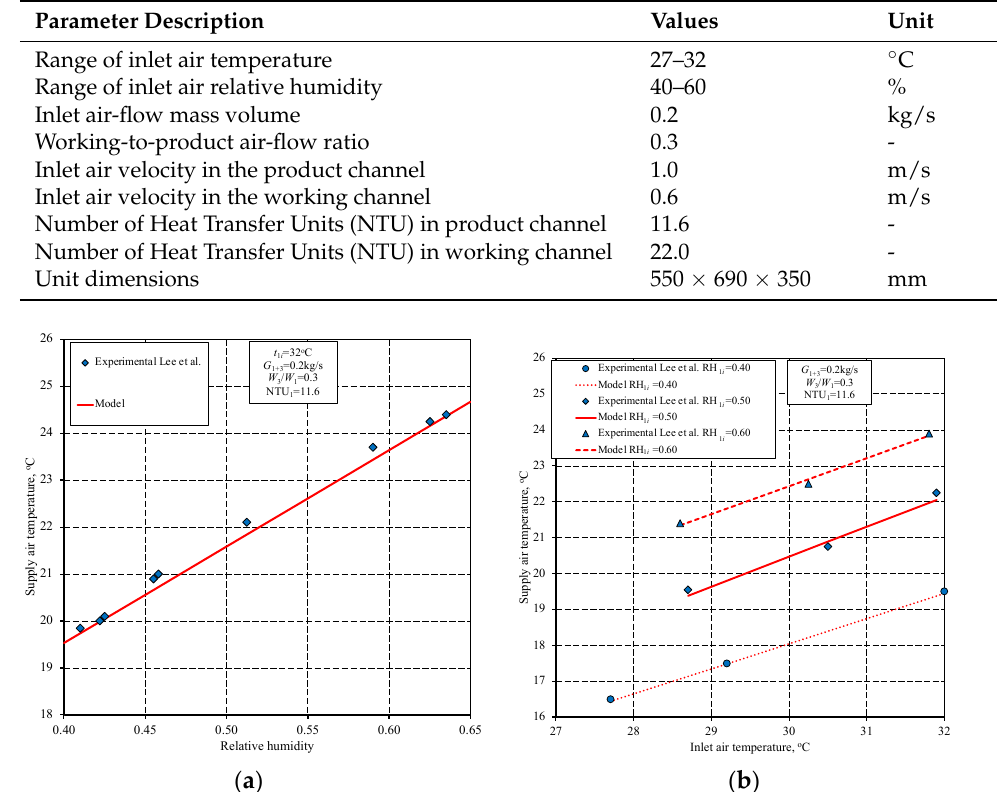
Figure A2. Supply air temperature obtained from experimental data [23] and simulation results for the regenerative dew-point evaporative cooler. ( a ) Variable relative humidity and constant inlet air temperature. ( b ) Variable inlet air temperature and constant relative humidity.